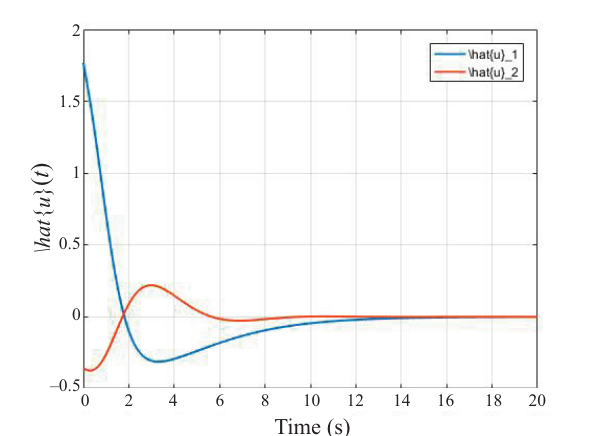
( t ) during stabilization maneuver. r